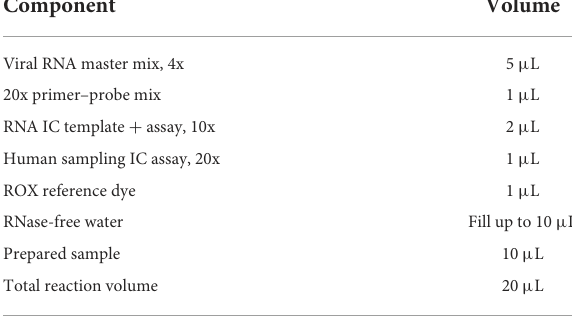
TABLE 1 Components of the reaction mix for the Qiaprep amp Viral RNA UM kit.